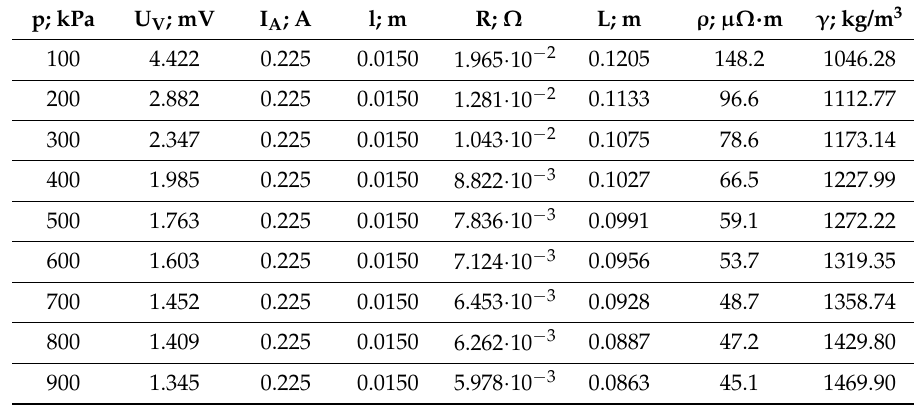
Table 2. Example set of resistivity and density values for synthetic graphite GS.